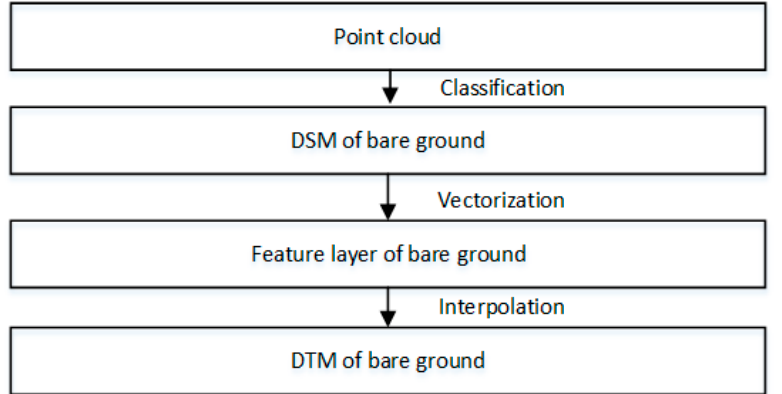
Figure 3. The workflow of creating a digital terrain model (DTM) raster of bare ground. To quantitively evaluate the surface height, 500 transect lines were made perpendicular to the prevailing wind direction to measure the pixel value of DTM. The surface height was measured by using the LPI method [13], as in Section 3.3.1 (it recorded the pixel value at 0.1-m intervals on the transect line). This experiment was conducted on the downwind area (which started from the centerline between upwind and downwind area) of Treatment 4 and Treatment Control of Block 3. Block 3 has a relatively flat terrain and the slope of Block 3 is 0.5 ◦ from northwest to southeast. Because of that, the relative altitude was used to represent the soil elevation in the different treatments. The mean of the relative altitude on the centerline was marked as 0 m for each treatment. The altitude of each pixel should be subtracted from the mean of the altitude on the centerline to get the relative